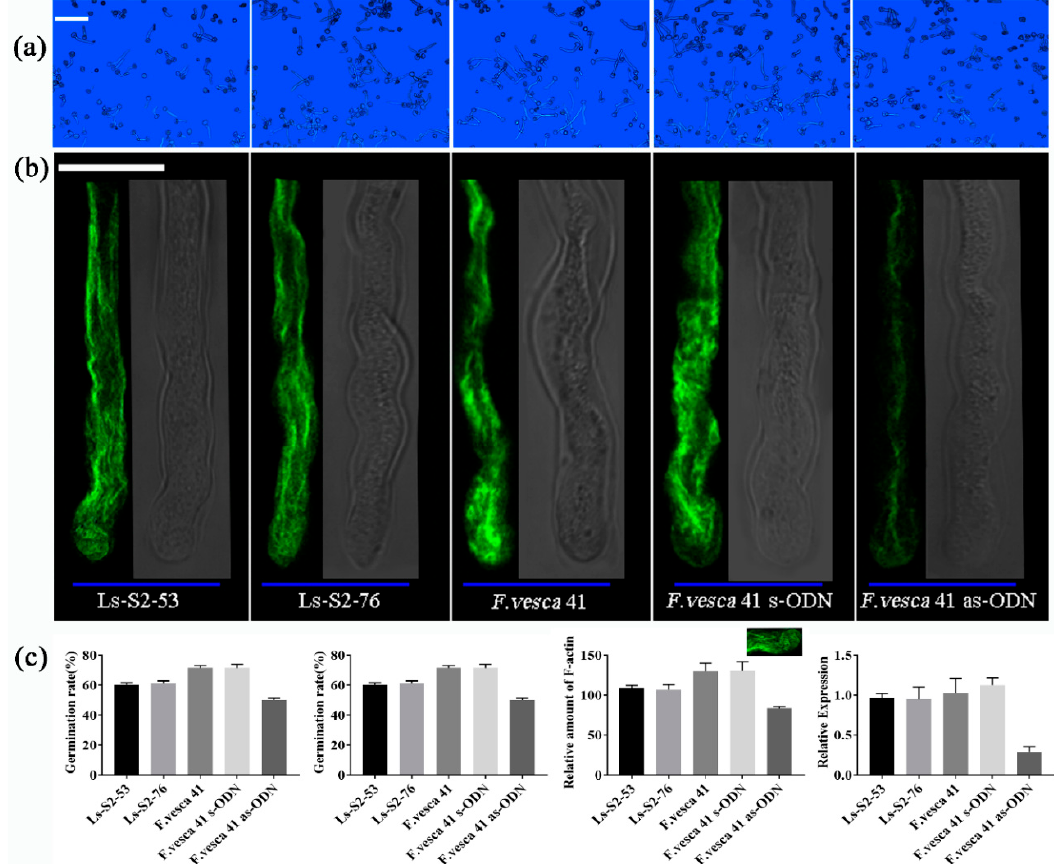
Figure 10. Pollen grain germination, pollen tube growth, and alterations of F-actin amount after antisense oligonucleotide (as-ODN) treatment. ( a ) Pollen grain germination and pollen tube growth for Ls-S 2 -53, Ls-S 2 -76, F. vesca 41, and F. vesca 41 of s-ODN treatment and F. vesca 41 of as-ODN treatment is displayed from left to right, respectively. Scale bar = 100 µ m. ( b ) The amount of F-actin of pollen tubes, where the green fluorescence indicates F-actin filaments and the gray area corresponds to the bright field. The F-actin intensity of pollen tube tip was measured and further analyzed with the ImageJ software using the processed images (subtraction of background). Scale bar = 10 µ m. ( c ) Pollen grain germination rate, average length of pollen tube, the F-actin density of pollen tube tip, and the relative expression of FIP2-like for the different samples and under the as-ODN treatments. Mean values and standard deviations (SD) were calculated from three replicates, p < 0.05.